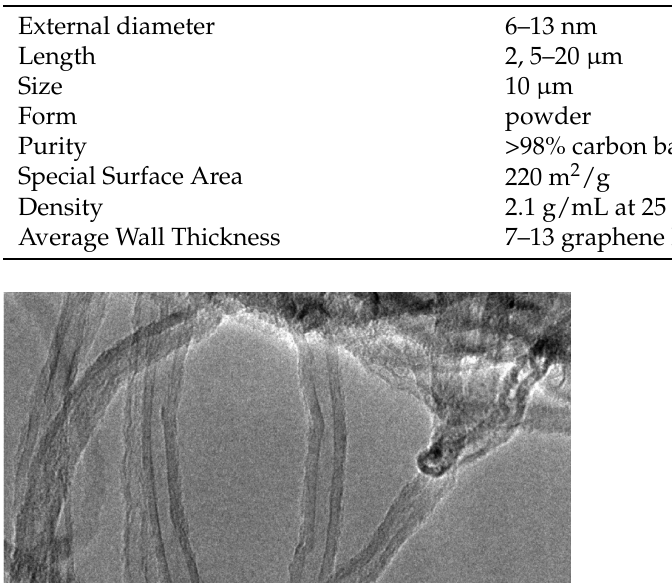
Table 1. Properties of multi-walled carbon nanotubes (MWCNTs).